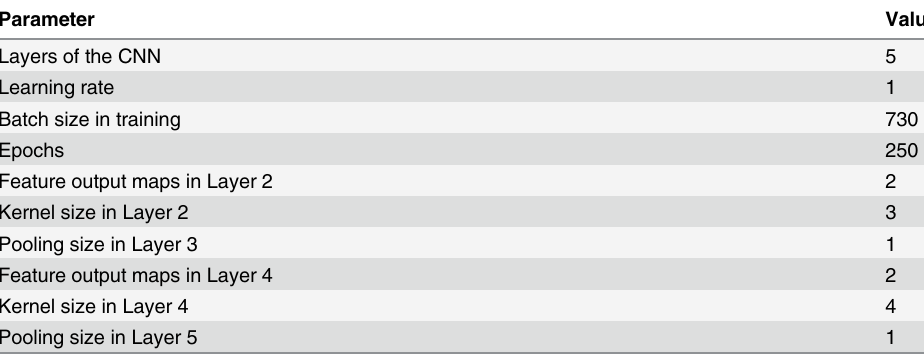
Table 2. Parameters in CNN modelling.